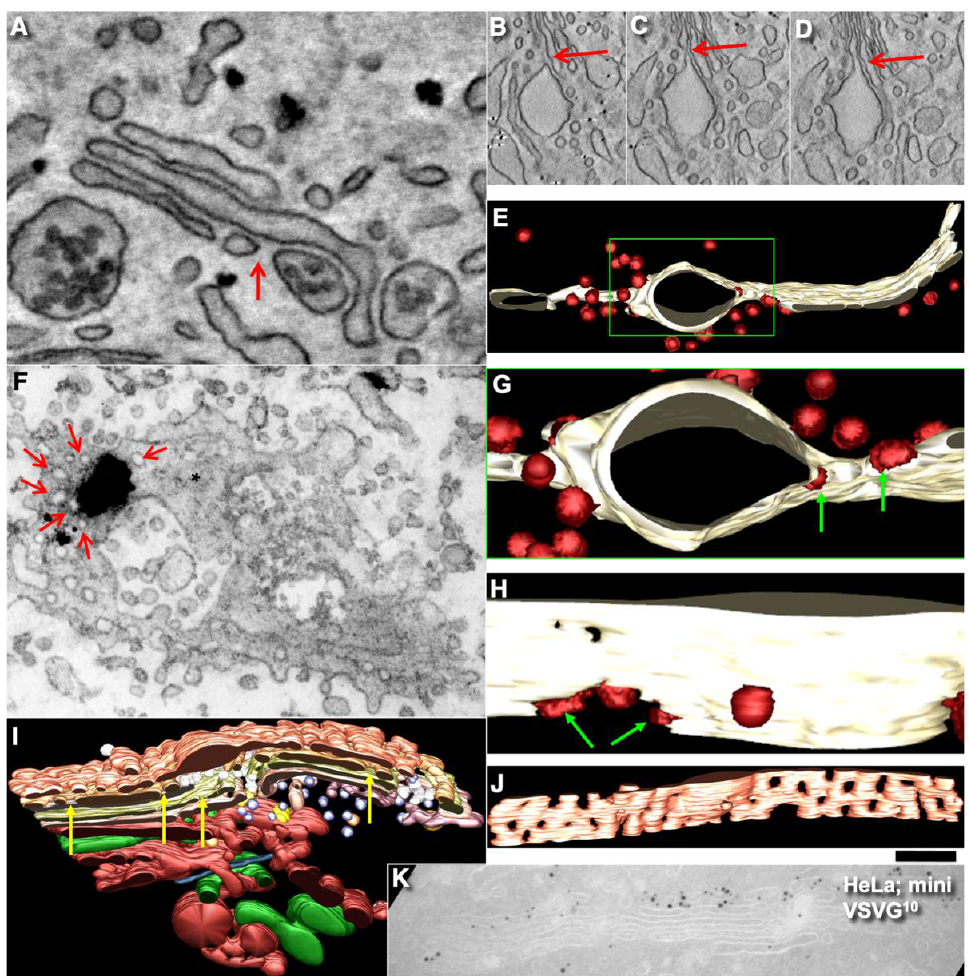
Figure 12. Pores separate cisternal distensions, which are filled with VLDLs ( A ) in hepatocytes and procollagen I in human fibroblasts ( B – J ). ( A – D ) All distensions are separated from the rest of the cisternae by pores (red arrows) around cisternal distensions. ( E , G , H ) Three-dimensional model of the Golgi cisterna during the mini-wave. Green arrows, COPI-coated buds (red) on the rim of the pore near the distension. ( F ) Mini-wave protocol. Tangential section of the medial Golgi cisterna. Immuno EM, enhanced nanogold particles show PC. Red arrows, pores surrounding PC aggregate (black blob) in the section. Asterisks indicate solid parts of Golgi cisternae. ( I , J ) Three-dimensional model of the Golgi complex with the PC-containing cisterna distension in the perforated cis-most cisterna at 2 min after the transport block. Yellow arrows, many pores in the medial cisternae. ( K ) HeLa cells. Mini-wave of VSVG. Low level of penetration of VSVG into the Golgi stack. Scale bars (nm): 165 ( A ); 420 ( B – D ); 240 ( E , F ); 75 nm ( H ); 280 ( I , K